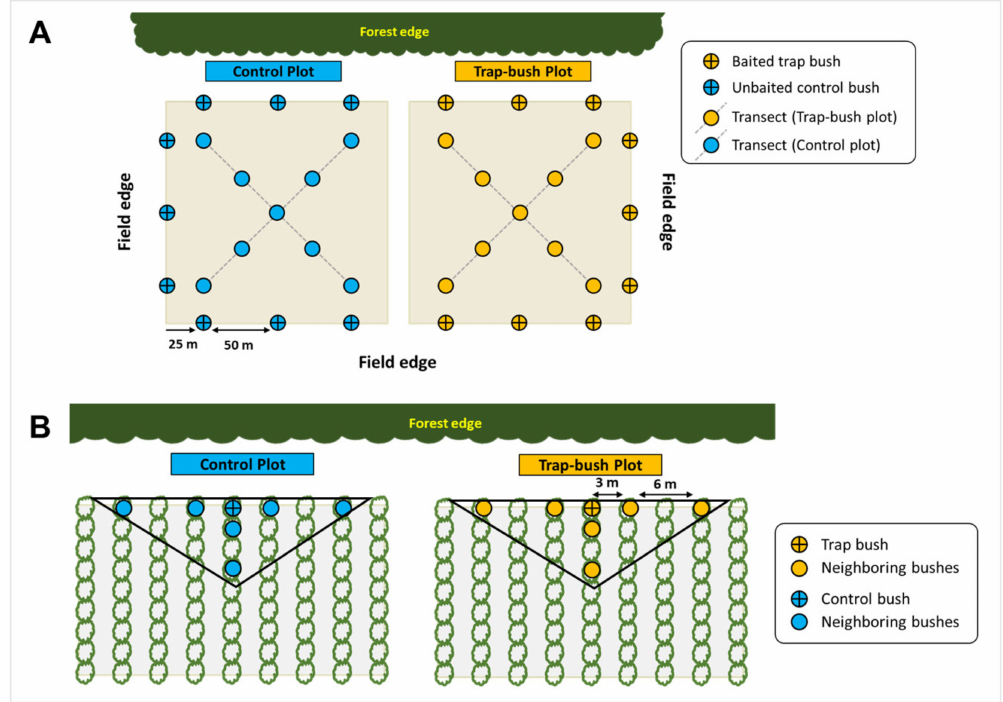
Figure 1. Layout of paired odor-baited trap-bush and unbaited (control) plots in commercial highbush blueberry farms ( A ). Sampling regimes used to compare fruit injury in trap bush and control plots. Each plot was ~2.5